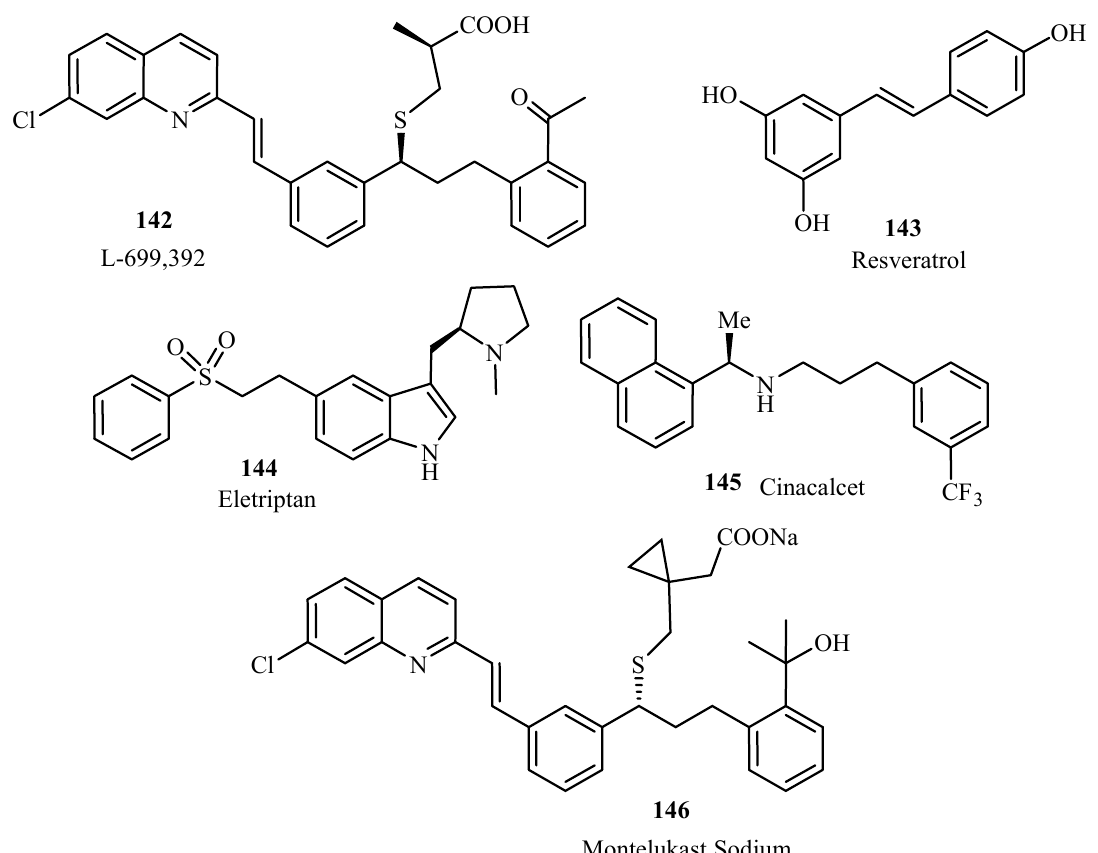
Figure 21. Additional fine chemical products produced on industrial scale using Heck reaction reviewed by Zapf and Beller [79].